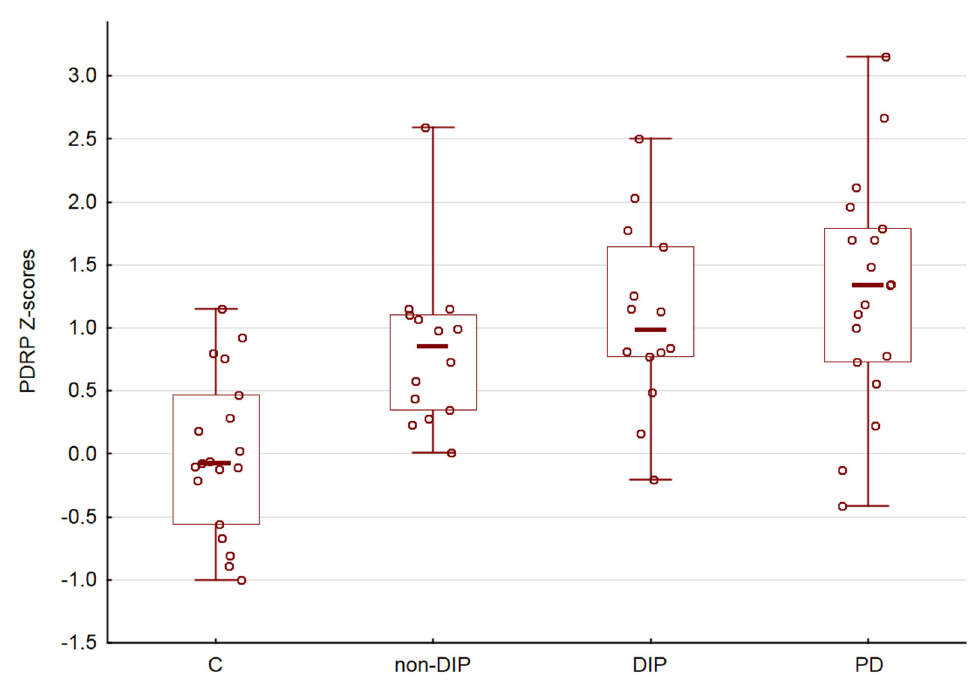
Figure 2. PDRP subject scores. Horizontal lines are medians, boxes reflect interquartile range, while whiskers—overall